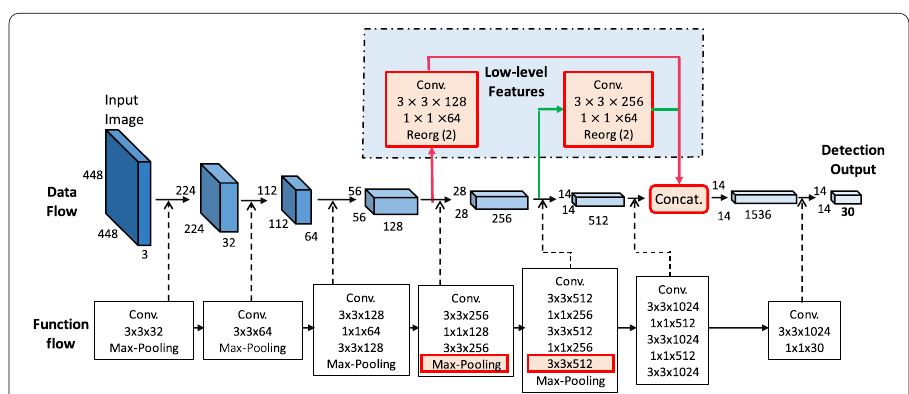
Fig. 5 The network structure of the proposed iYOLO